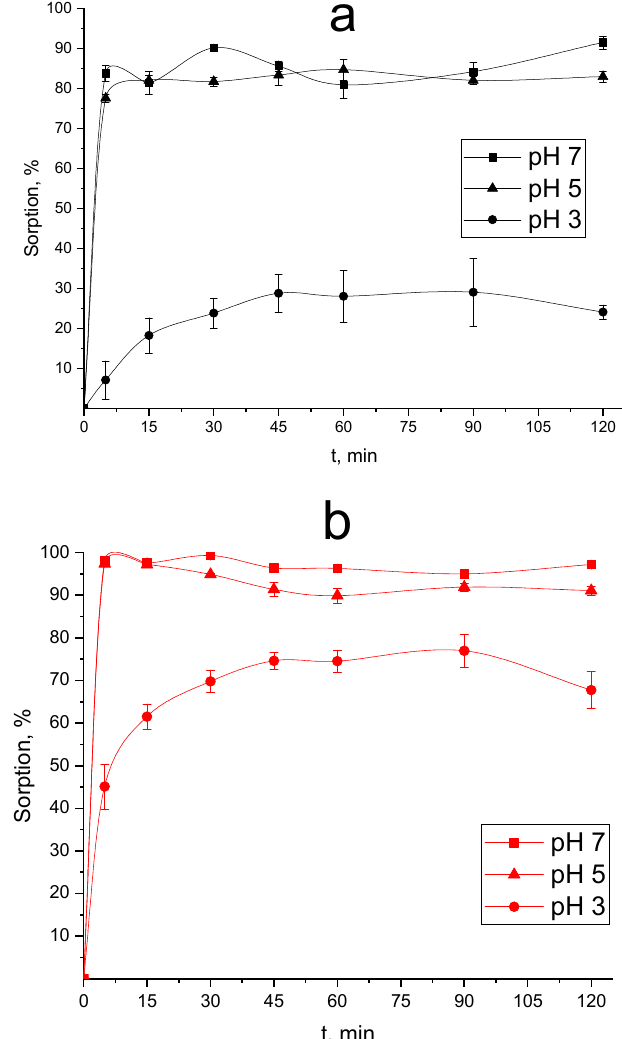
Figure 3. The influence of pH of the initial solution to the 68 Ga sorption onto nanodiamonds (ND) ( a ) and their oxidized forms (ND–COOH) ( b ) at m/V ratio of 100 μ g/mL and at 25 °C.